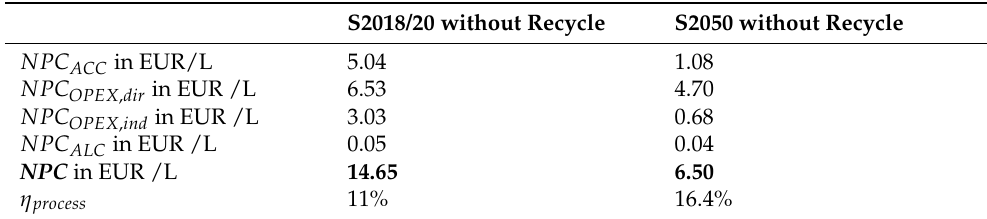
Table 9. Results (net production costs NPC and process efficiency) using no recycle